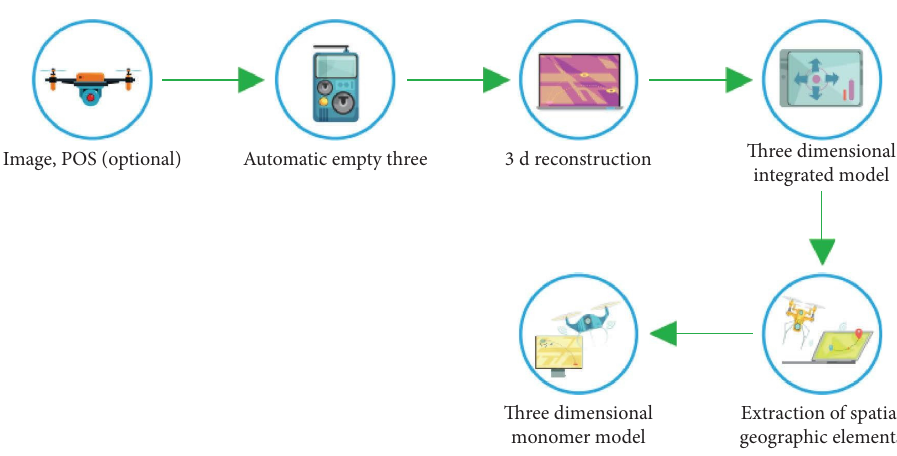
Figure 1: Tilted real scene 3D modeling